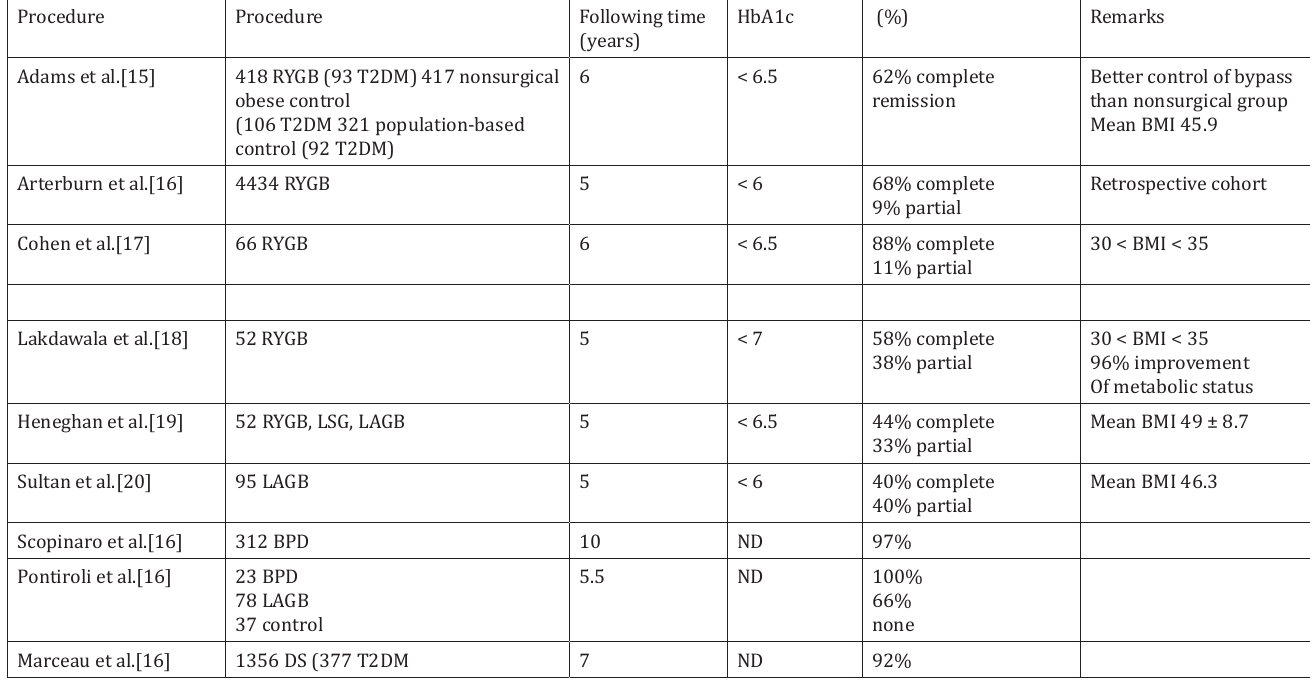
Bariatric surgery and diabetes: literature review